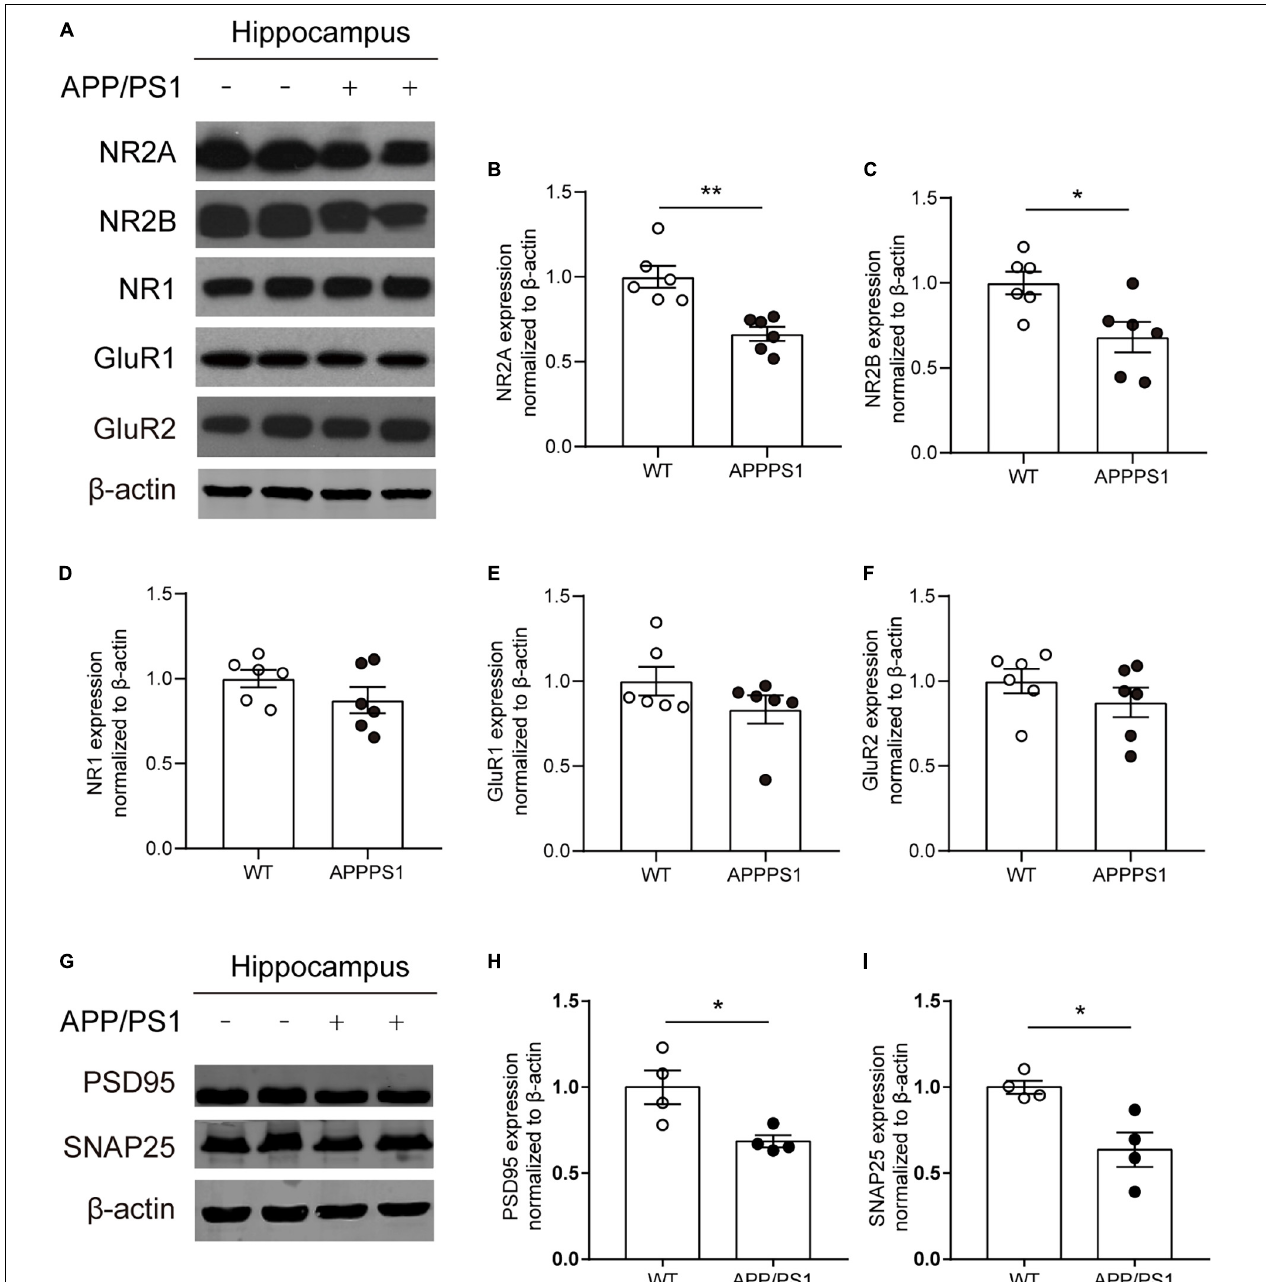
FIGURE 6 | The expression of synapse-associated proteins and glutamate receptor subunit proteins in the CA1 area of 8-month-old WT and APP/PS1 mice. (A) Representative western blots of glutamate receptor subunits. (B–D) Quantitative of NMDAR subunits expression showed a significant decrease of NR2A and NR2B expression ( n = 6 mice/group, * p < 0.05, ** p < 0.01, unpaired t -test) in the hippocampus in 8-month-old APP/PS1 mice compared with WT mice, but there was no difference on the expression of NR1 from two groups. (E,F) Quantitative of AMPA receptors subunits (GluR1, GluR2) expression showed no change in hippocampus from 8-month-old APP/PS1 mice and WT mice. (G) Representative western blots of PSD95 and SNAP25. (H,I) A significant decrease of the levels of PSD95 and SNAP25 in the hippocampus from 8-month-old APP/PS1 mice compared with WT mice ( n = 4 mice/group, * p < 0.05, unpaired t